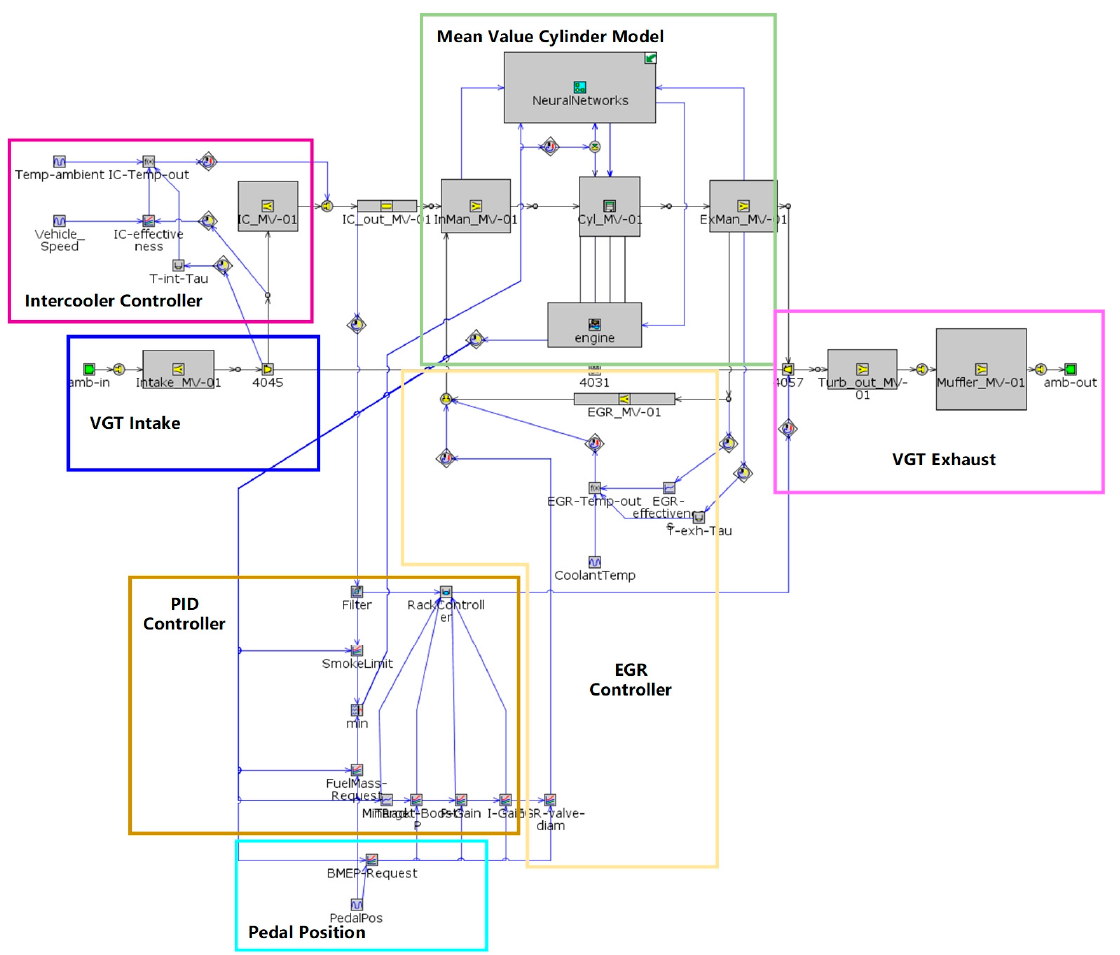
Figure 3. Layout of the GT-Suite mean value model.